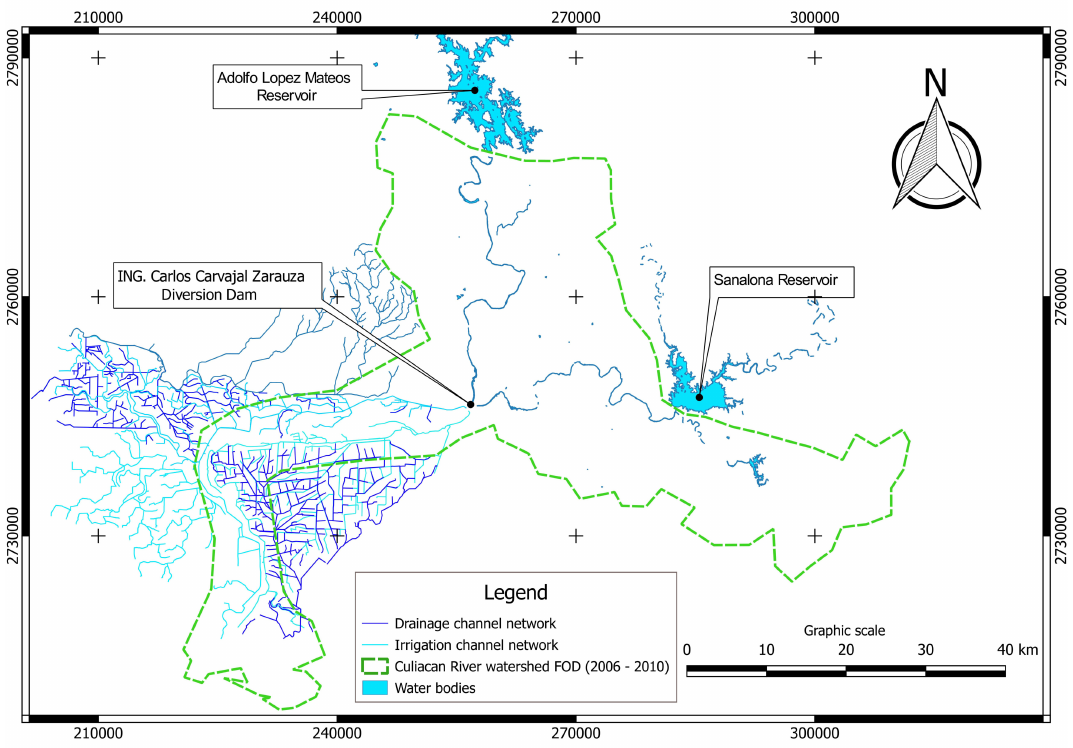
Figure 6. Culiacan River watersheds published by CONAGUA (2016a) in 2006 and 2010; hydrography of the study area (INEGI, 2017a) and drainage channel networks of Irrigation District 010 Culiacan Humaya (CONAGUA,